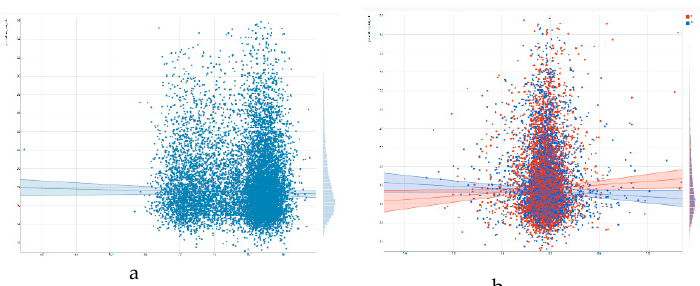
a b Figure A2. Regression coefficient of the effect of NAc functional connectivity with the frontoparietal network on BMI at baseline. ( a ) Overall association (blue), ( b ) association in females (red) and males (blue). Table A1. Formula for replication models.